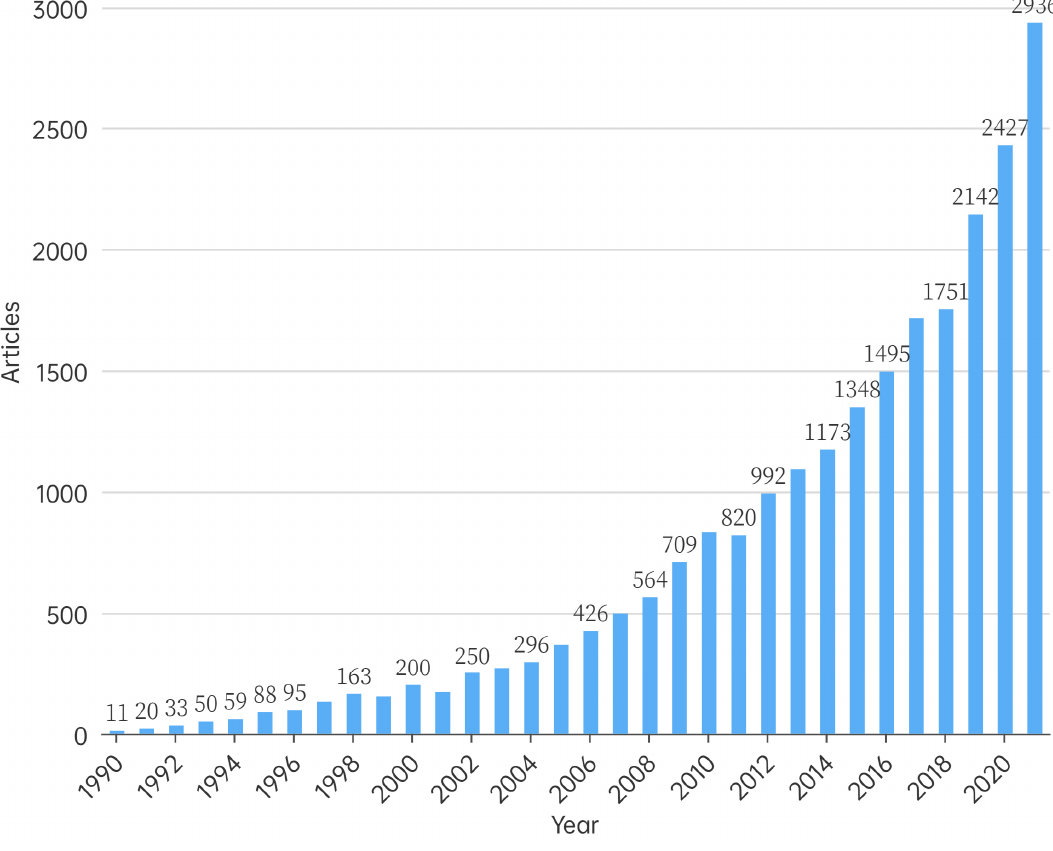
Figure 2. Volume of published articles on ecological restoration from 1990 to 2022.